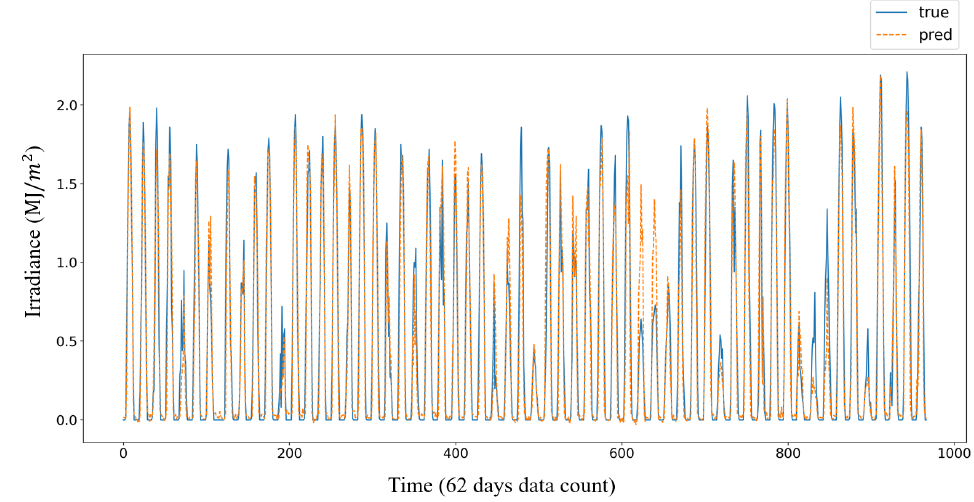
Figure 8. Irradiance compare Real data with Prediction data.